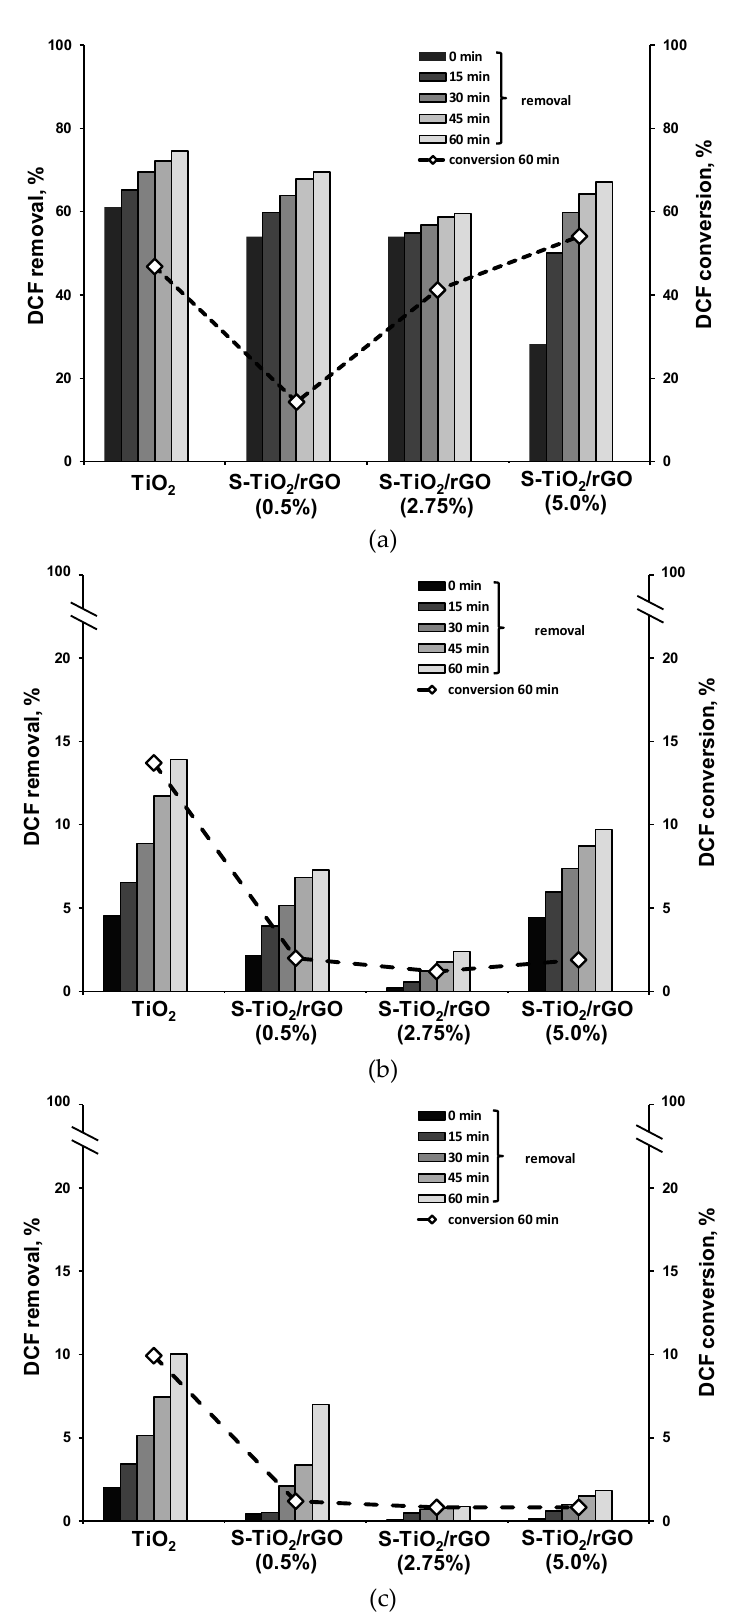
Figure 8. Removal and conversion of diclofenac (DCF) during photocatalytic treatment by solvothermally obtained TiO 2 and S-TiO 2 /rGO composites at ( a ) pH 4, ( b ) pH 6, and ( c ) pH 8.